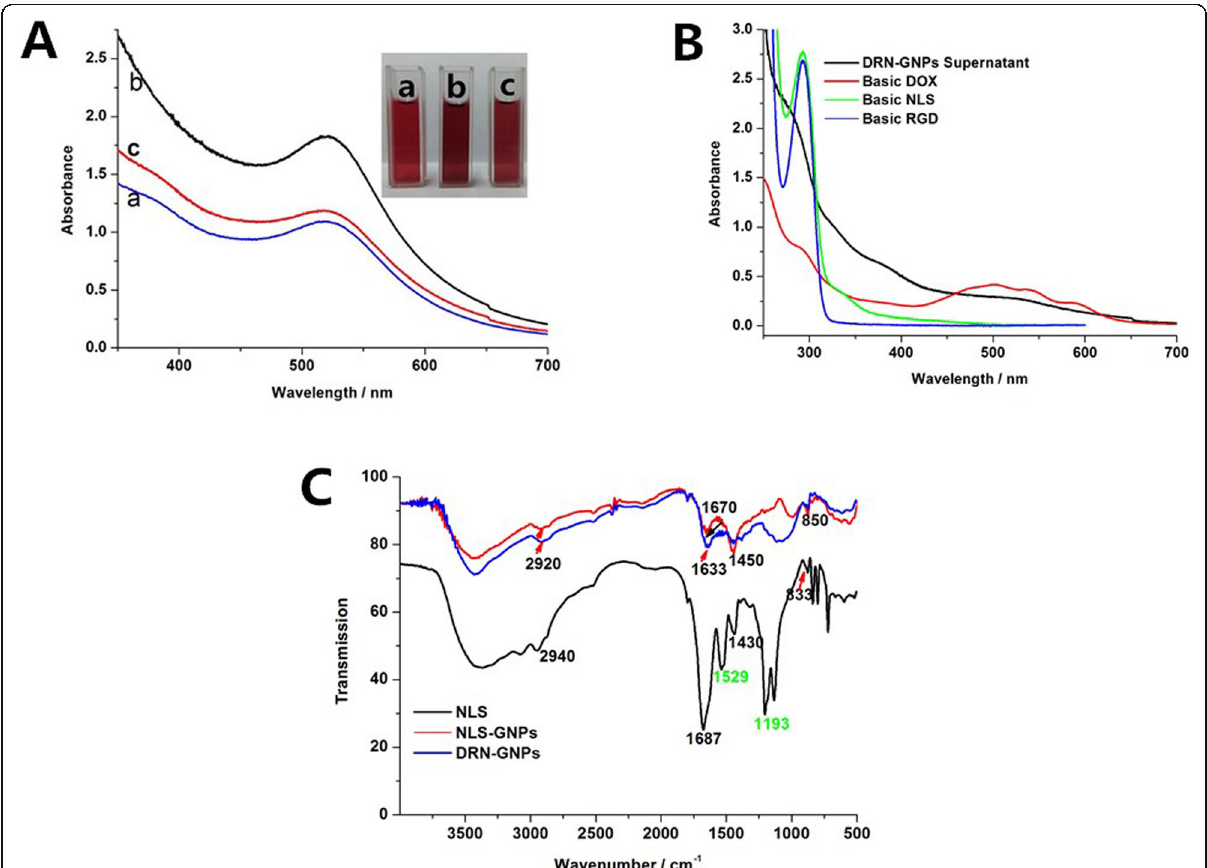
Fig. 2 a UV-Visible absorption spectra and the photo images of DOX – GNPs ( a ), NLS-GNPs ( b ), and DRN-GNPs ( c ). b UV-Visible absorption spectra of basic DOX, RGD peptides, NLS peptides, and the supernatant of DRN-GNPs. c FTIR spectra of NLS peptides, NLS-GNPs, and DRN-GNPs. The distance between the GNPs ’ spectrum and NLS peptides ’ spectrum are enlarged for the contrast